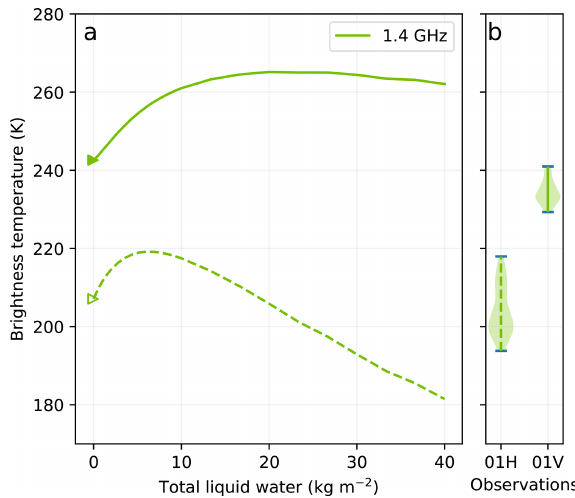
Figure 18. Brightness temperature at Roi Baudouin as a function of the depth of the 30cm thick wet snow layer at the L band at V-pol (solid) and H-pol (dashed). The simulated dry brightness tempera- tures are marked by the